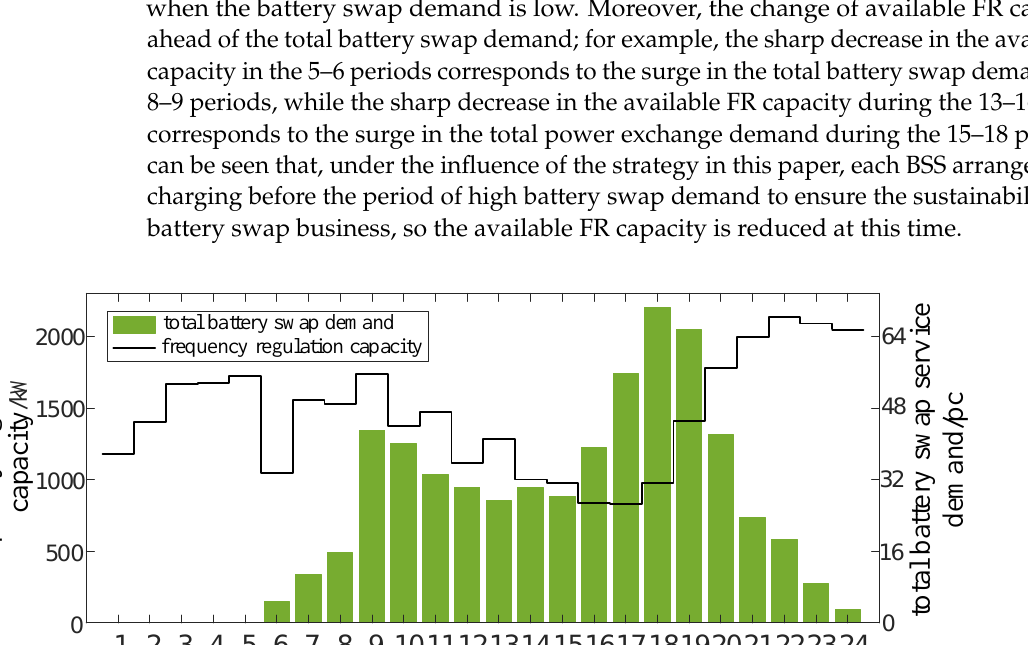
Figure 3. Available FR capacity of each BSS.